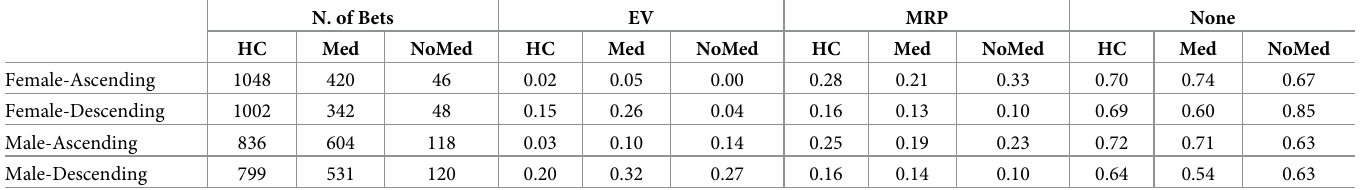
Table 5. Numbers and percentages of bets in agreement with EV, MRP, or none for HCs, medicated OCD patients (Med), and non medicated OCD patients (NoMed), across the four groups defined by the combination of sex and ascending vs. descending presentation of the bets. N. of